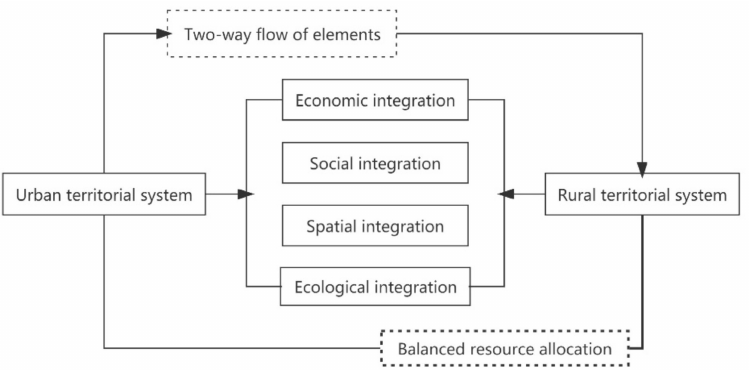
Figure 1. Conceptual framework for integrated urban-rural